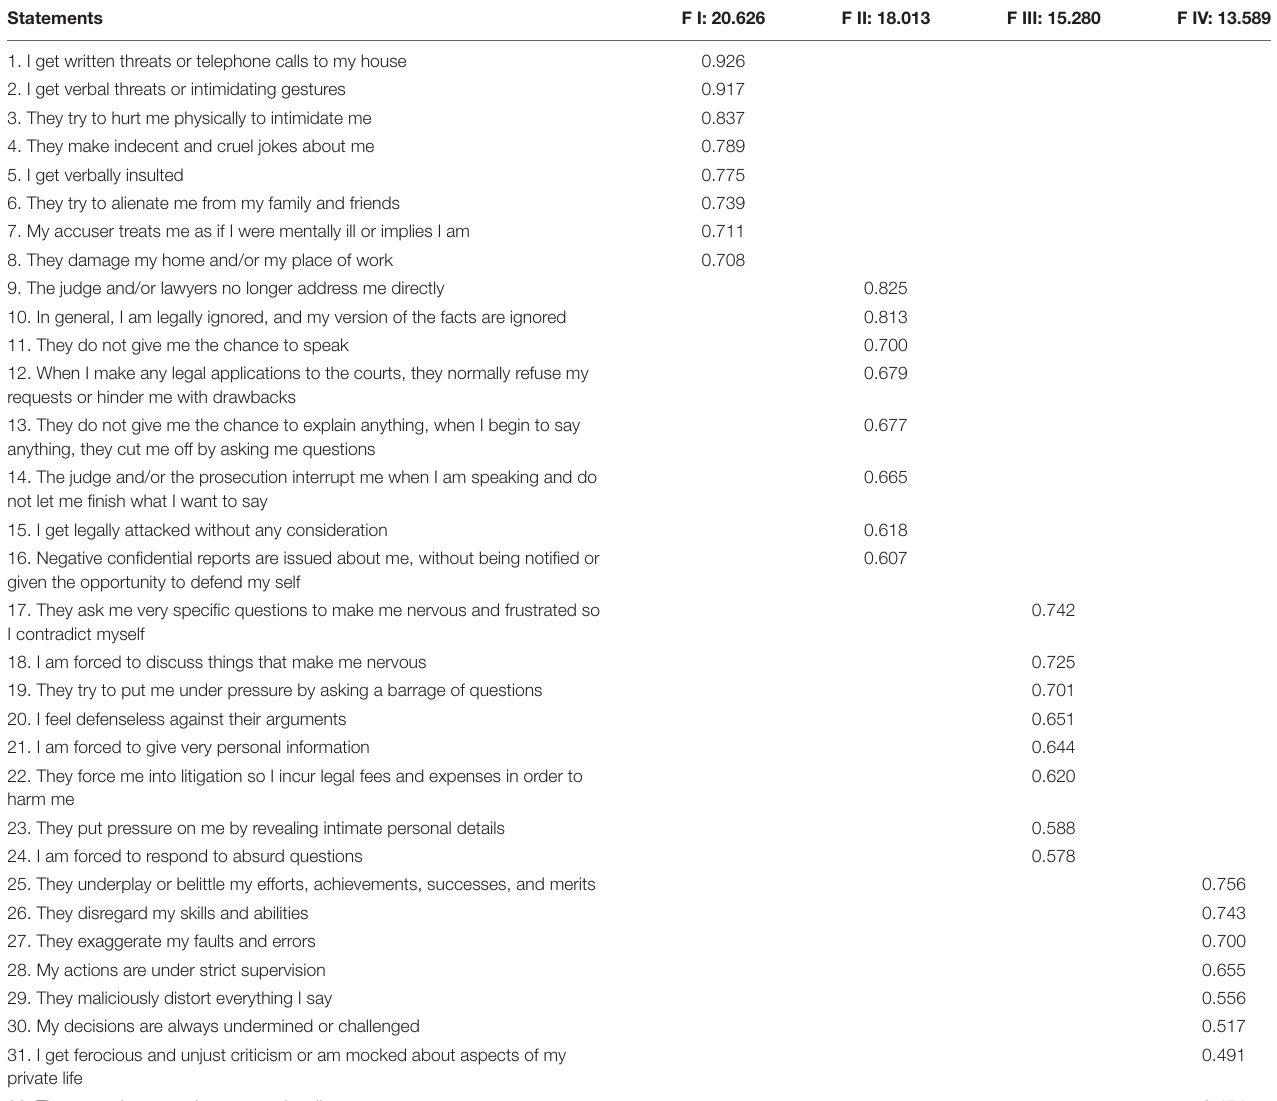
TABLE 1 | Factorial analysis after rotation solution of the Legal Harassment